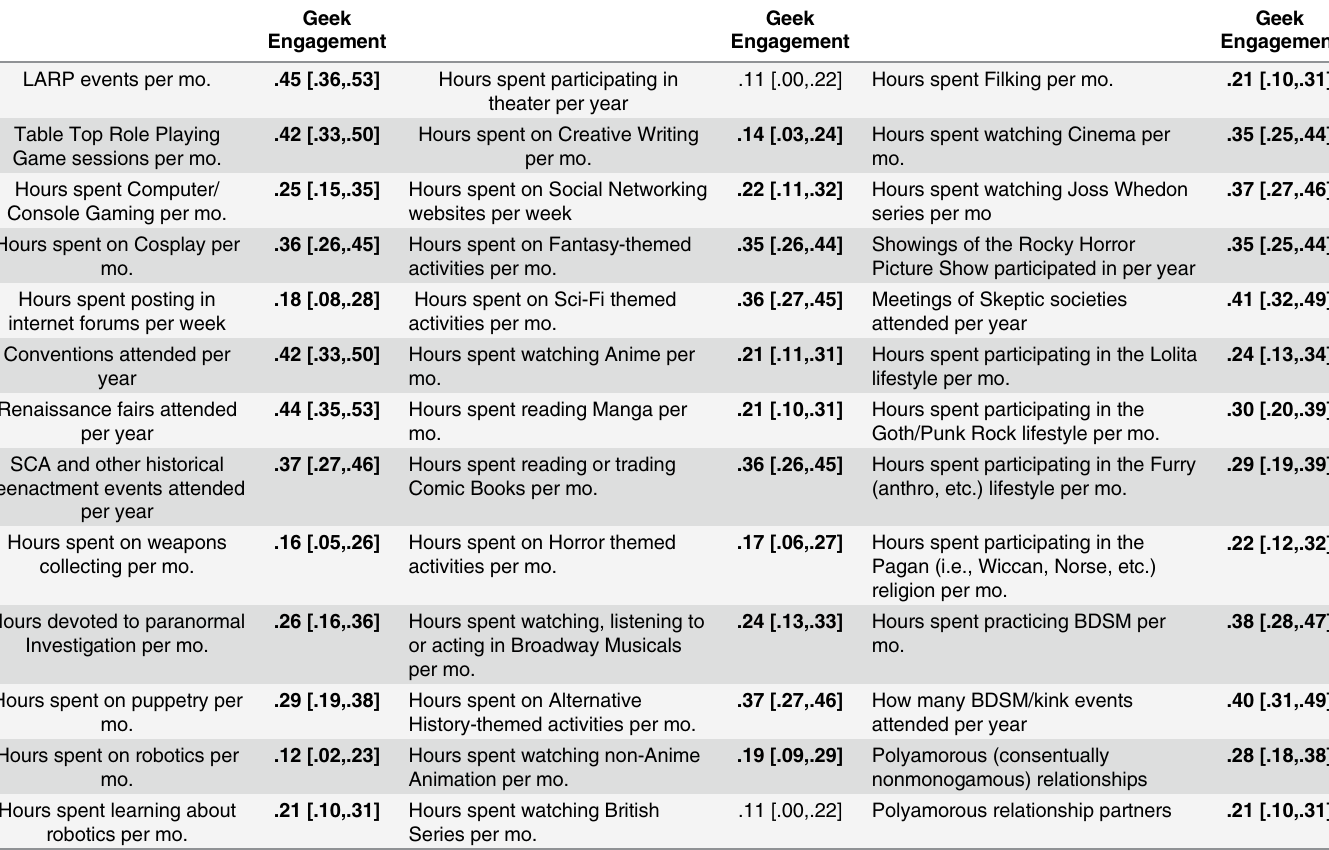
Table 7. Correlations between Geek Engagement and Frequency of Geek Activities.